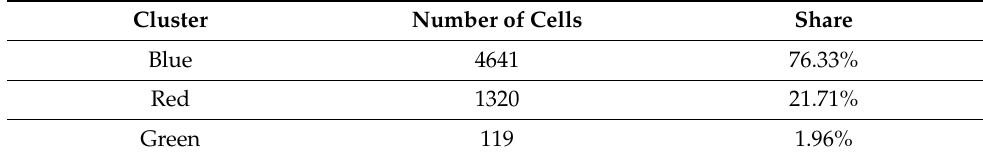
Figure 13. Distribution of most informative features across clusters: Perimeter, major axis, and minor axis. The boxes pre- sent median, first and third quartiles, and whiskers the furthest data point not further than from the quartile than 1.5 × IQR (interquartile range). Table 3. The sizes and proportions of clusters in the feature space.